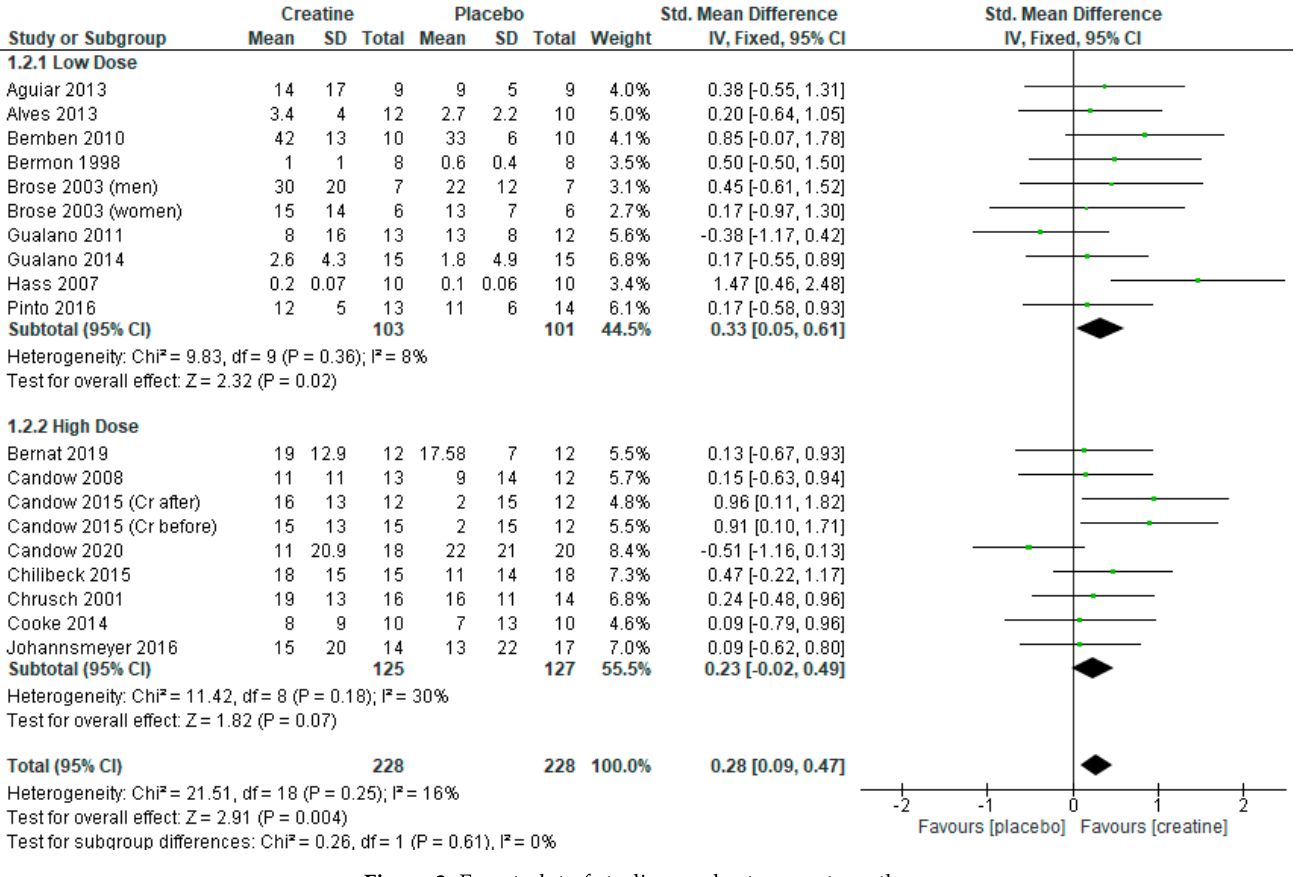
Figure 2. Forest plot of studies on chest press strength.